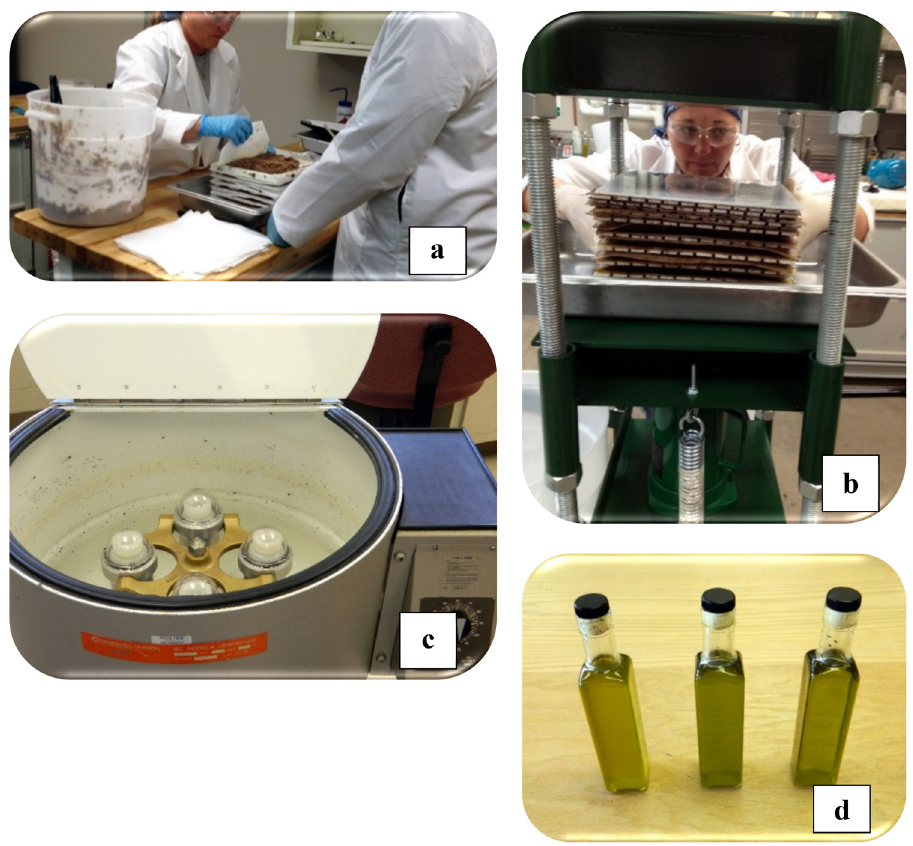
Figure 2: Olive oil preparation: preparing paste for hydraulic pressing ( a ) , hydraulic pressing ( b ) , centrifuging and decantation of oil ( c ) , and samples of bottled oil ( d )